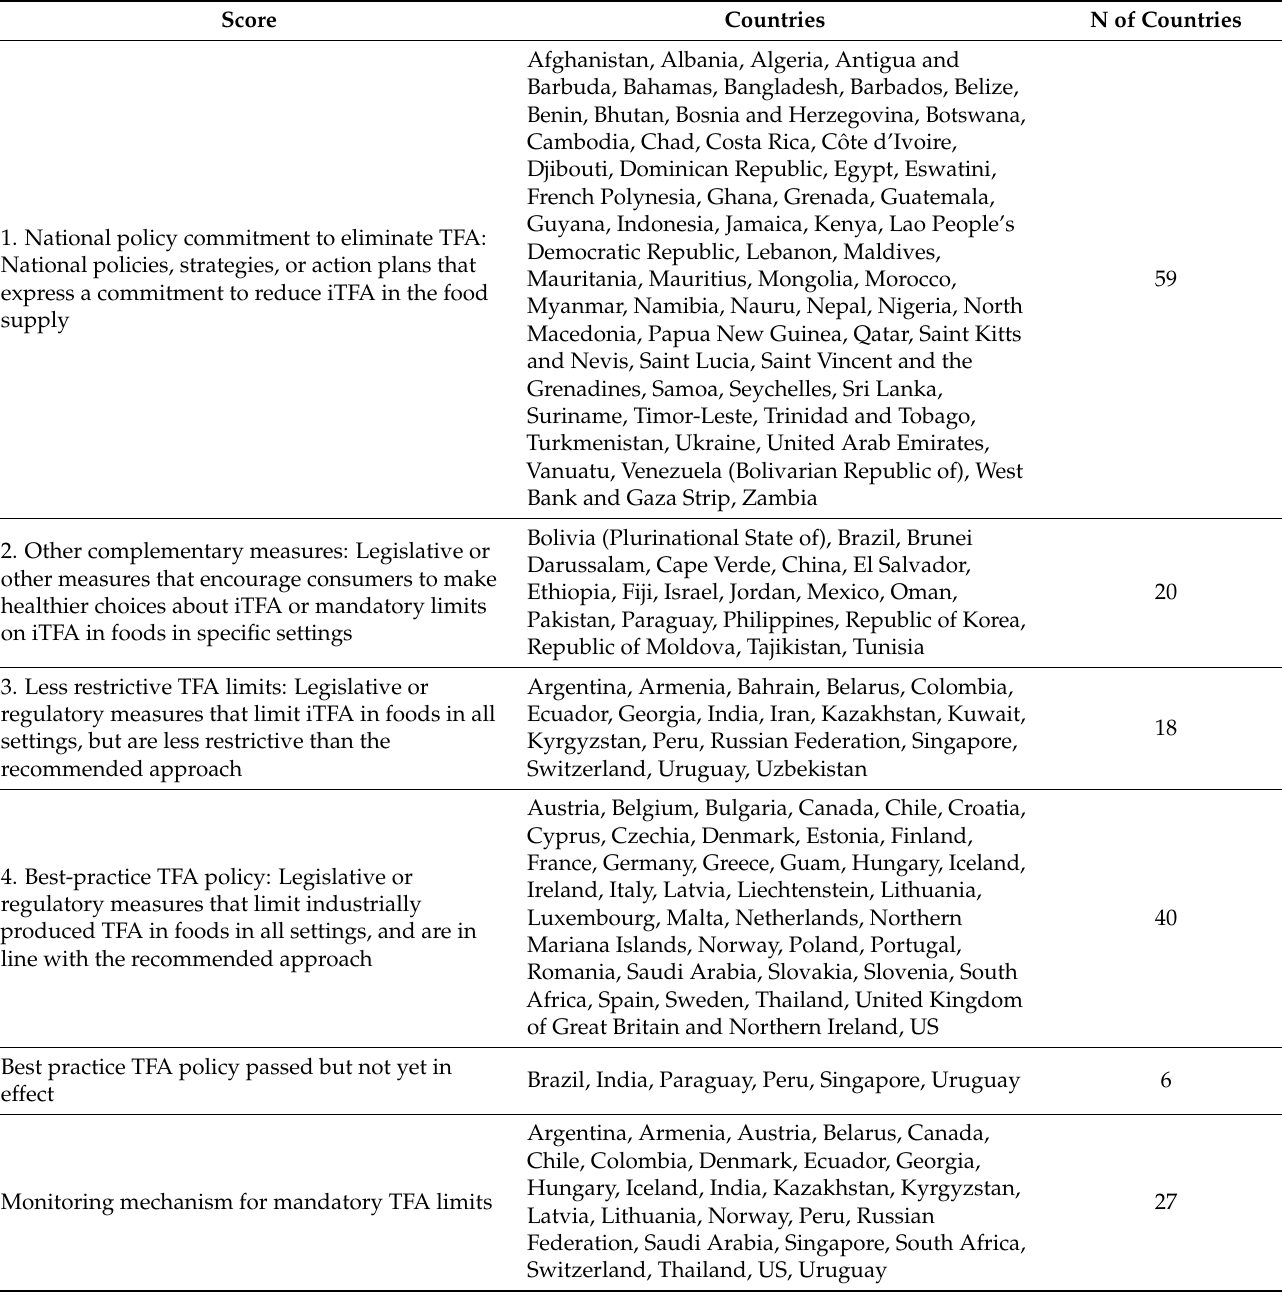
Table 1. TFA Country Score Card developed by the WHO